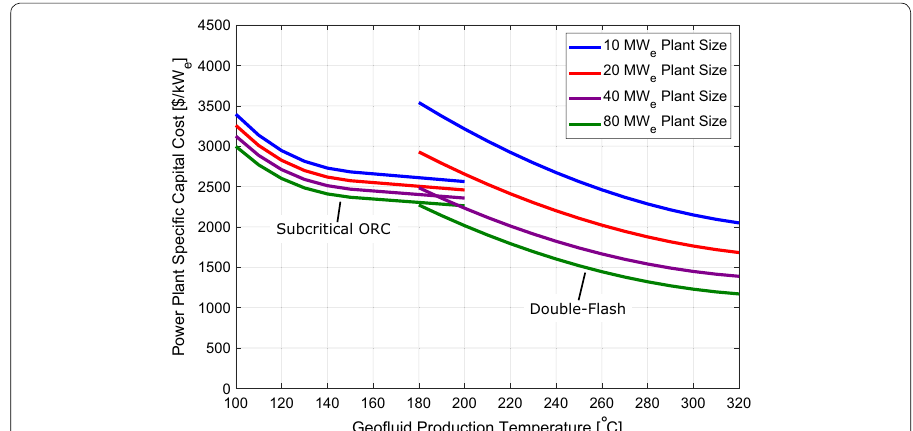
Fig. 4 GEOPHIRES built-in capital cost correlations for subcritical ORC and double-flash power plants. Plotted cost data includes 15% contingency, but excludes indirect